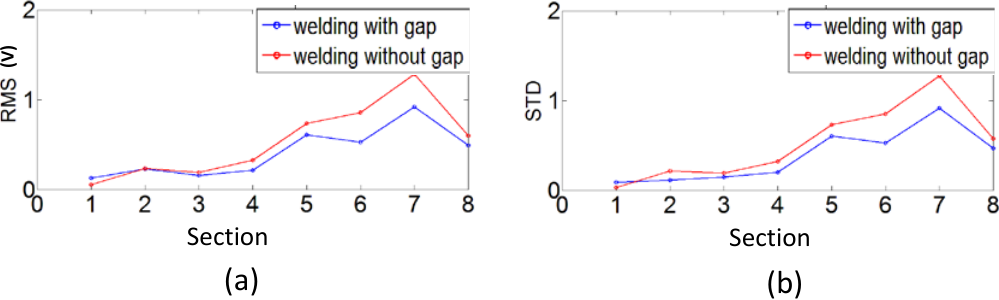
Figure 10. Average of RMS values and standard deviations (STDs) for 20 samples: ( a ) RMS and ( b ) STDs.